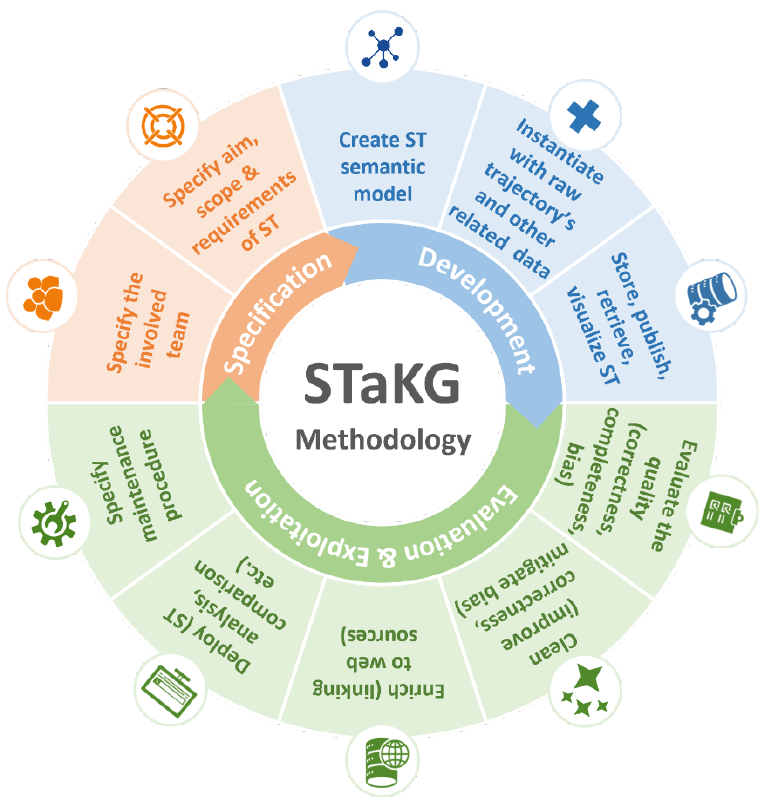
Figure 3. The STaKG methodology (ST refers to a sematic trajectory).